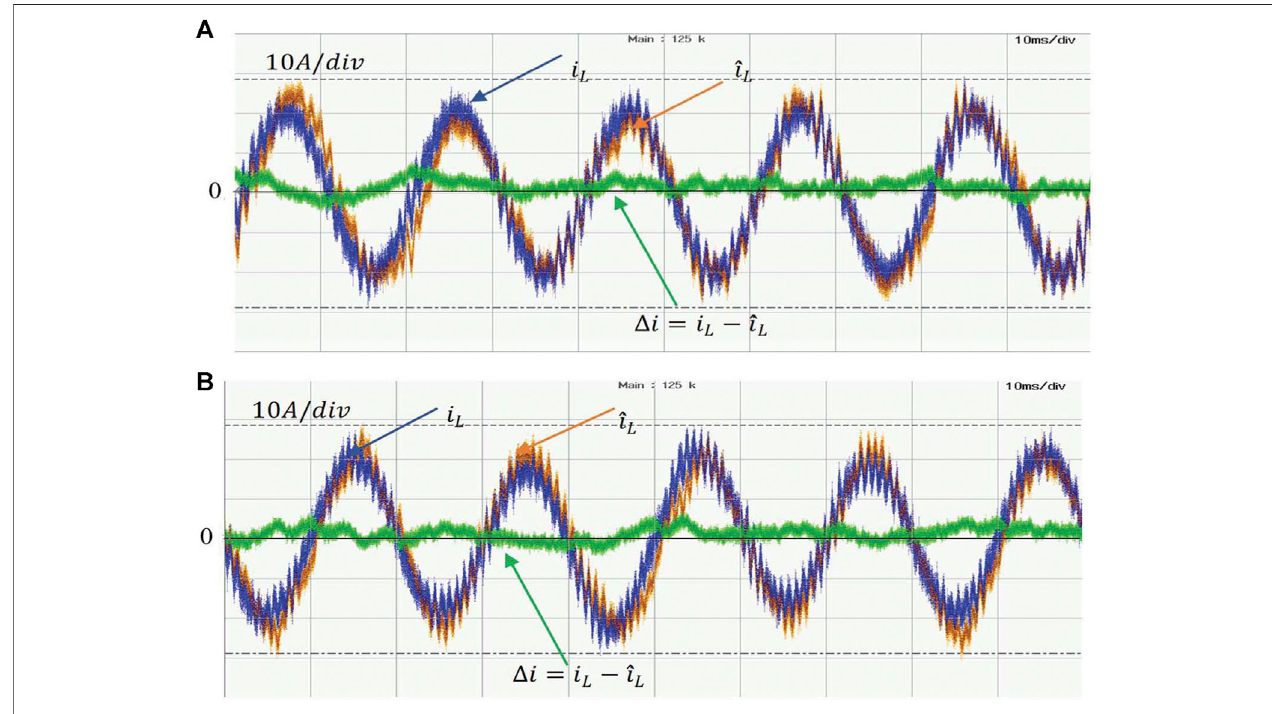
FIGURE 14 | Experimental waveforms of real inductor current i L , observed inductor current (cid:15) i L and error Δ i L . (A) Island model, (B) grid-connected model.